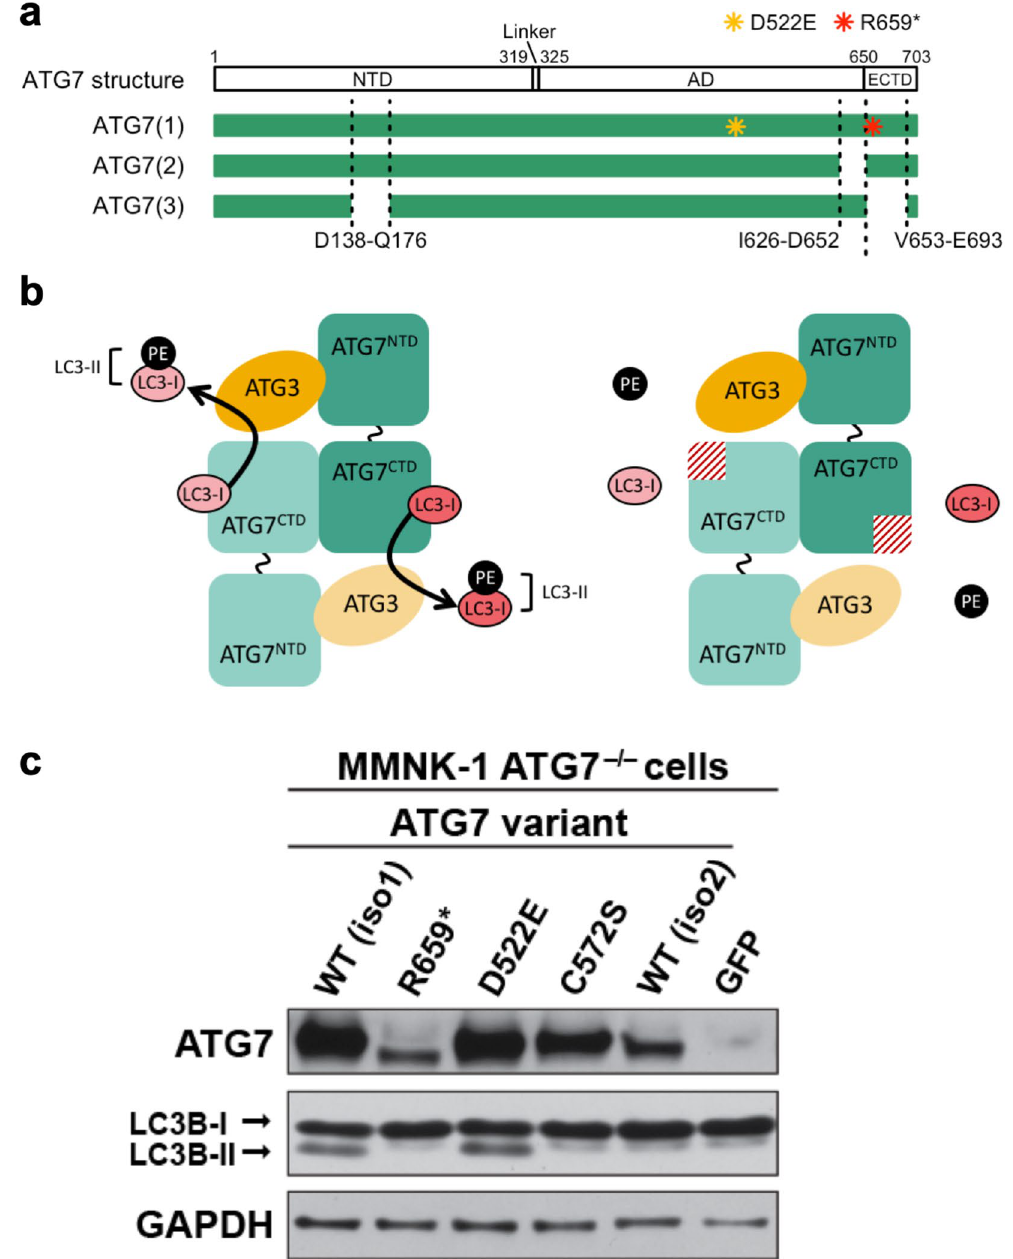
Figure 4. ATG7 p.R659* is a loss-of-function mutation. ( a ) The predicted structure of ATG7 contains an N-terminal domain (NTD), linker region, adenylation domain (AD), and extreme C-terminal domain (ECTD). The p.R659* (R659*) and p.D522E (D522E) mutations are indicated in isoform 1 of the ATG7 protein. ( b ) Predicted functional impact of ATG7 p.R659* mutation. Wildtype ATG7 and ATG3 conjugate ATG8 proteins such as LC3 with phosphatidylethanolamine ( PE ). We determined that the ATG7 R659* mutant lacks PE conjugation activity to LC3 as a result of the ECTD truncation. ( c ) Expression of ATG7 WT isoform 1 (iso1) and D522E restored the lipidation of LC3B whereas expression of ATG7 R659*, C572S, or WT isoform 2 (iso2) failed to lipidate LC3B from LC3B-I to LC3B-II. A Myc-tag was used to detect the expression of exogenous ATG7 from various vectors. A GFP expressing vector was used as a negative control. GAPDH was used as the loading control. Original blots are presented in Supplementary Fig. S9